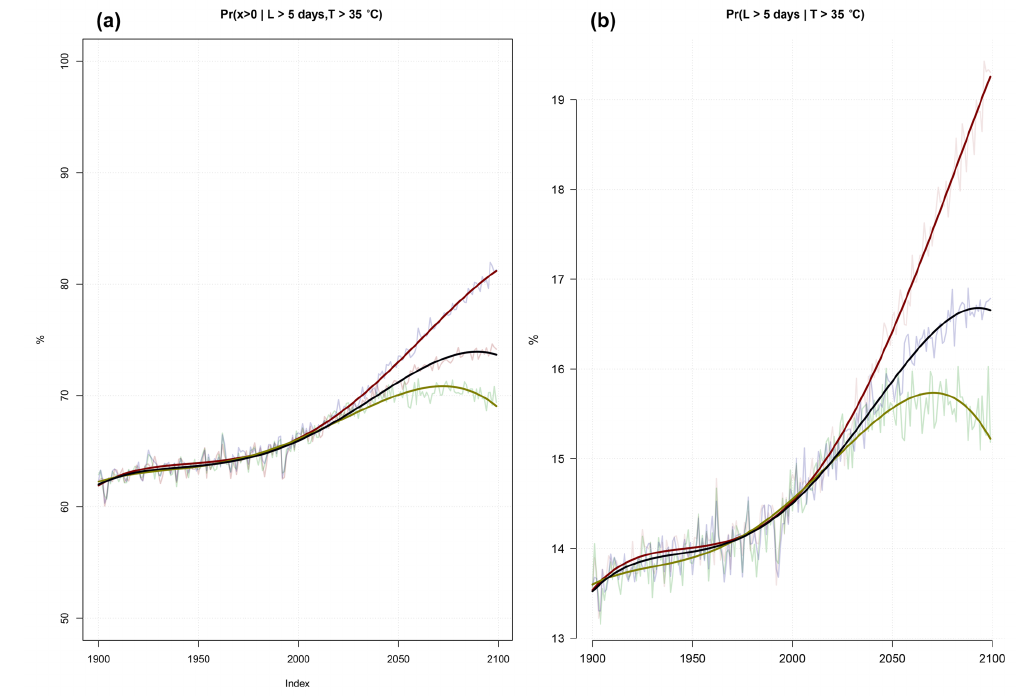
Figure 4. Projected probability of (a) one or more events with daily maximum temperature above 35 ◦ C lasting longer than 5 days during the February–April season for Patna and (b) the probability that the heatwave lasts more than 5 days, given temperature above 35 ◦ C. These curves represent one of the stations presented in Tables 1 and 2. The fitted trend curves were fourth-order polynomials for different emission scenarios (Benestad, 2003), where green represents RCP2.6, blue RCP4.5, and red